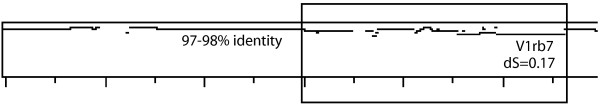
Unexpected low orthology in the vicinity of the V1rb7 gene. PipMaker plot with chained alignments illustrating the contiguous high level of orthology (97–98%) evident upstream and downstream of the musculus V1rb7 gene. Hash marks indicate 1-kb intervals. The lower level of more disrupted synteny is confined to the region encompassing the musculus V1rb7/spretus YUA.5 orthologs, whose synonymous substitution rate (dS) is ~17%, or approximately 8.5-fold more diverged than expected. This gene pair might have been subject to gene conversion in one or both lineages.